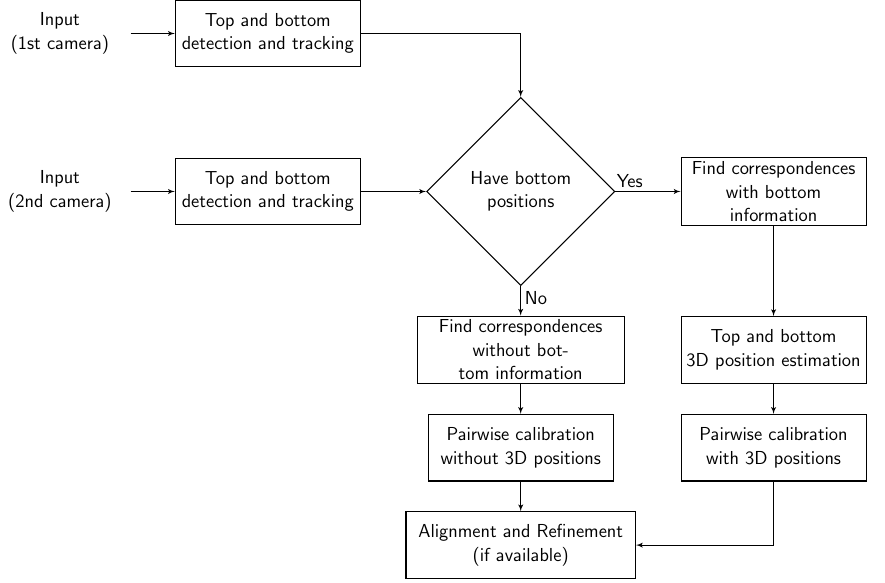
Figure 1. Block scheme of the proposed calibration